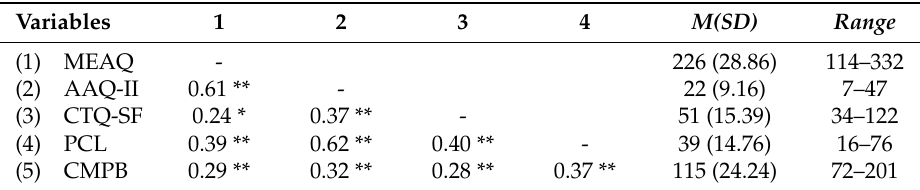
Table 1. Bivariate correlations for study